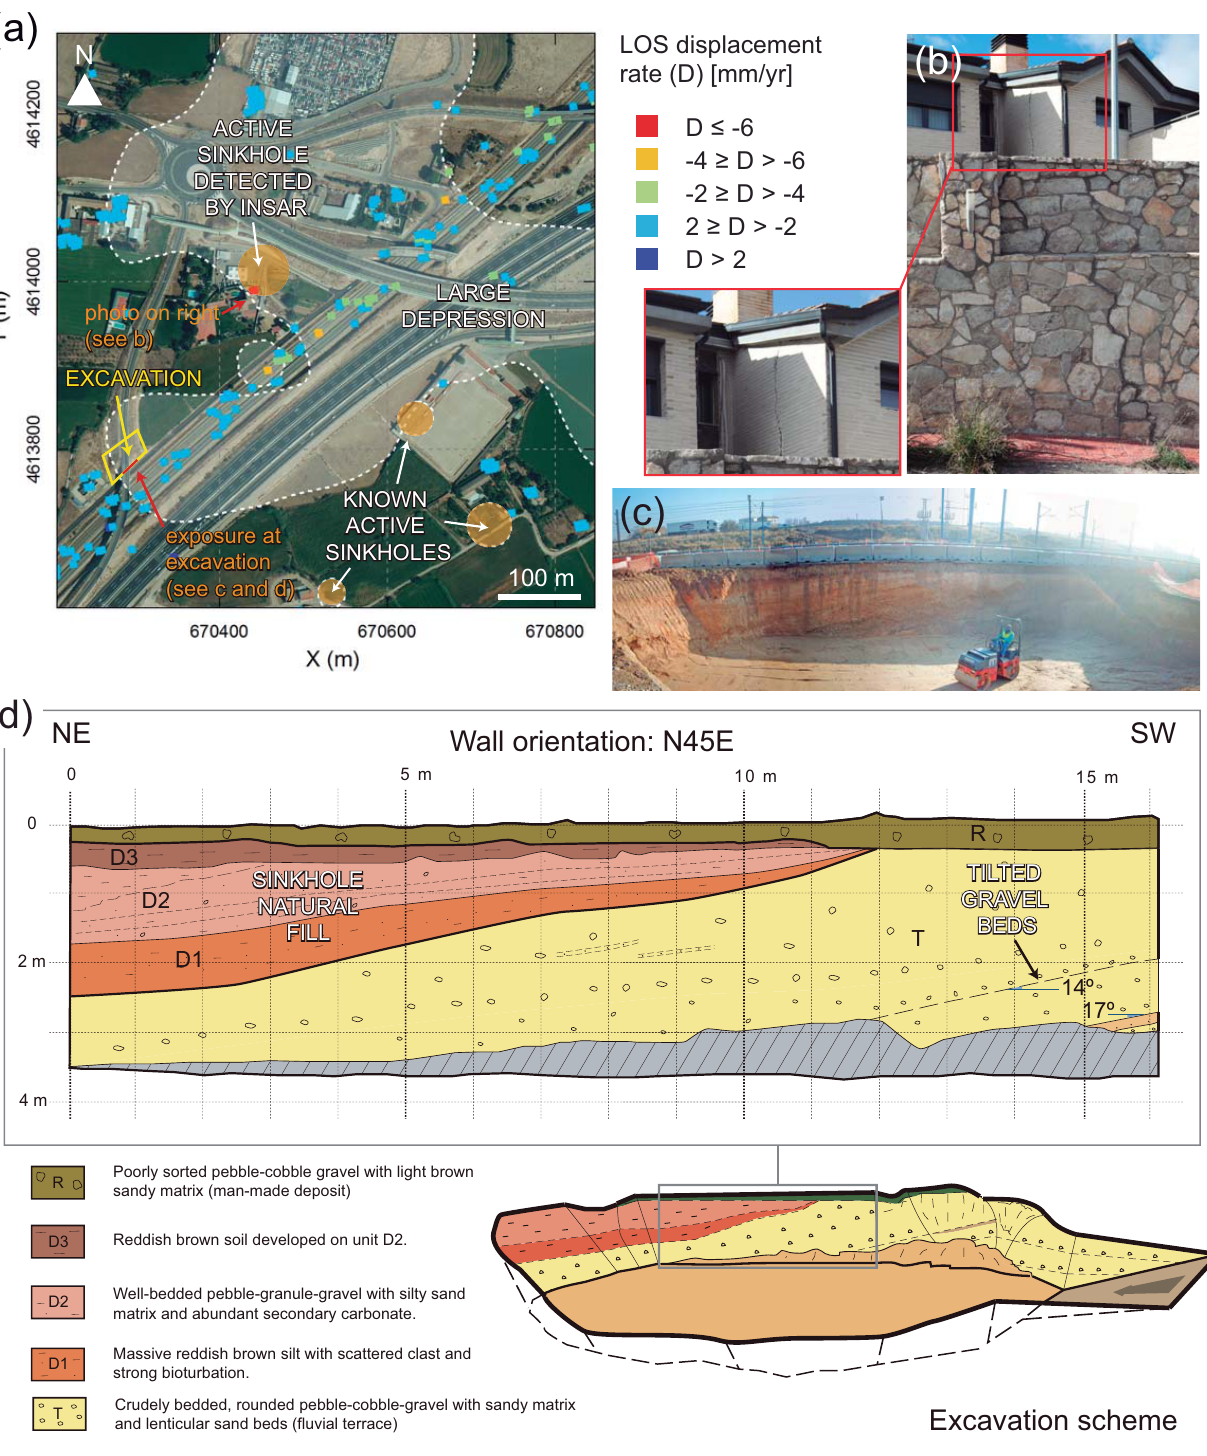
Figure 5. Evidence of karst subsidence associated with the track of the Madrid–Zaragoza high-speed railway. (a) Orthoimage of 2009 with ENVISAT DInSAR PS data indicating the main sinkholes and large karst depressions. (b) Cracks on a house where ENVISAT DInSAR map indicate subsidence. (c) General view of the excavation indicated in (a) . (d) Log and scheme of the walls of the excavation. Note the wedging-out of the sinkhole fill and the tilted terrace gravel